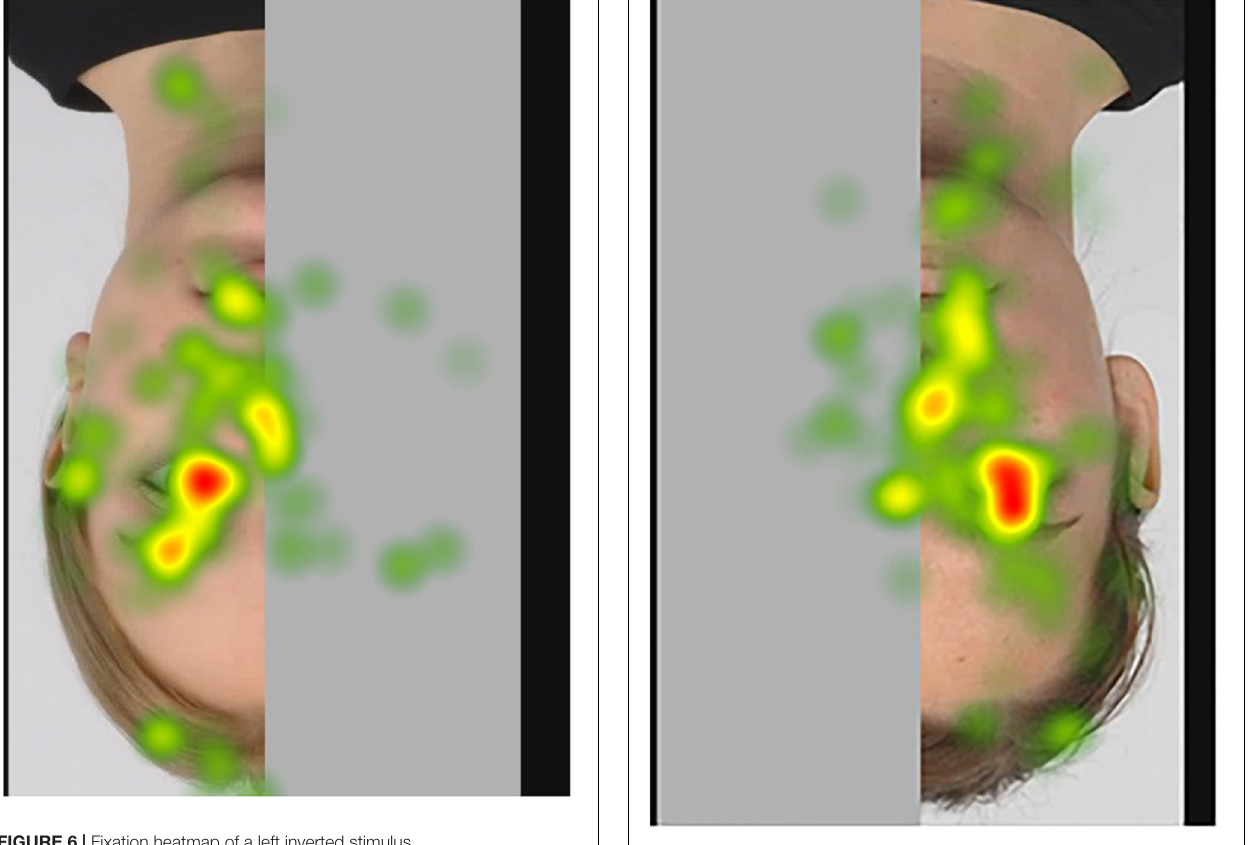
FIGURE 7 | Fixation heatmap of a right inverted